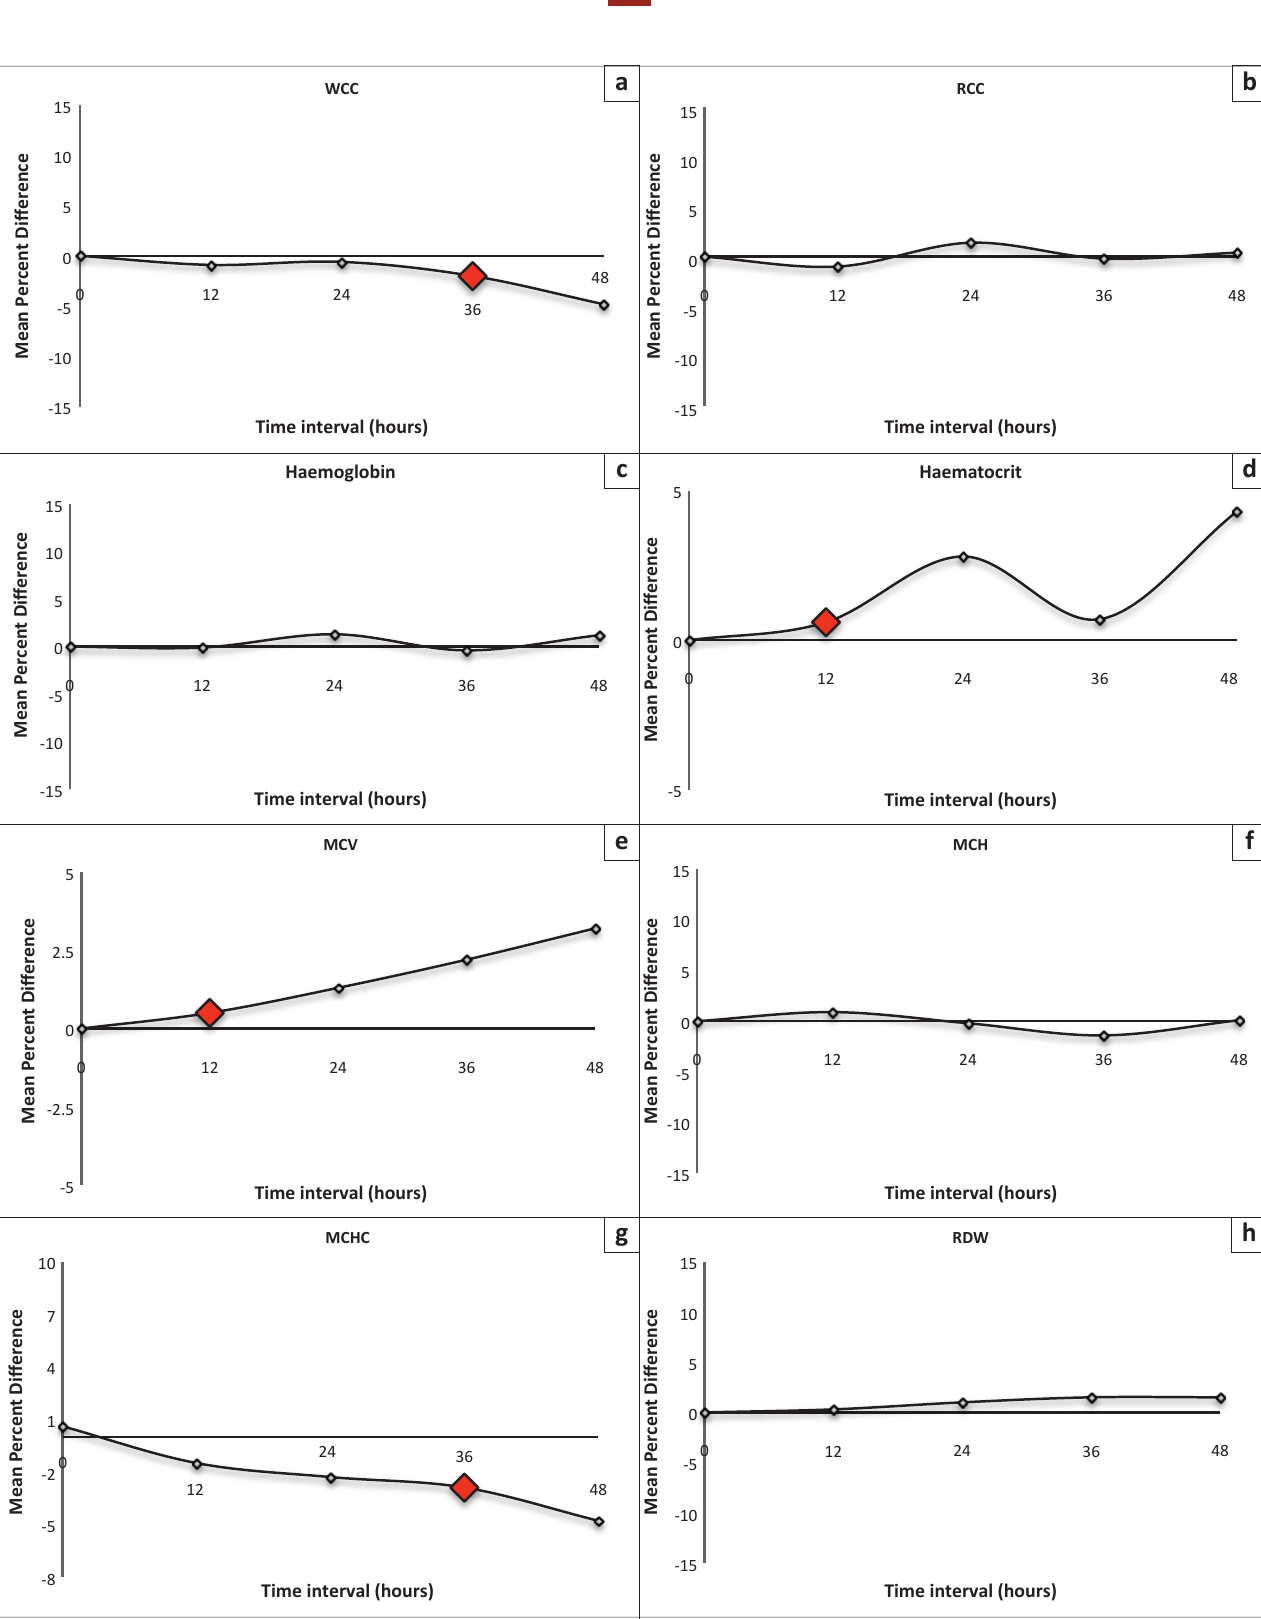
FIGURE 1: Stability analysis (mean percent difference) at room temperature (18 °C – 24